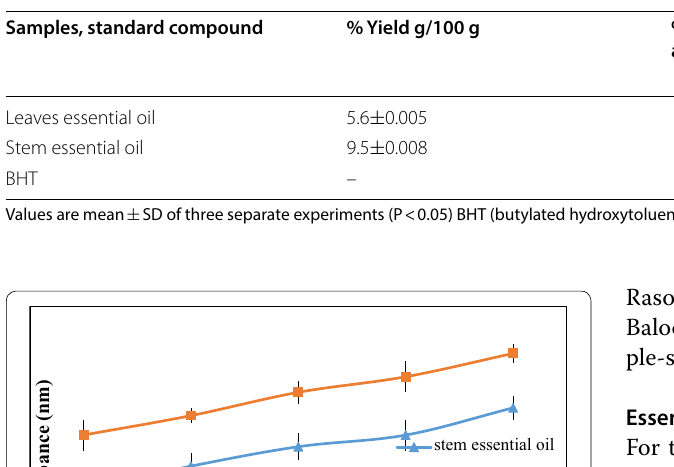
Table 2 % Yield and antioxidant analysis of D. mucronata Royle essential oils Samples, standard compound